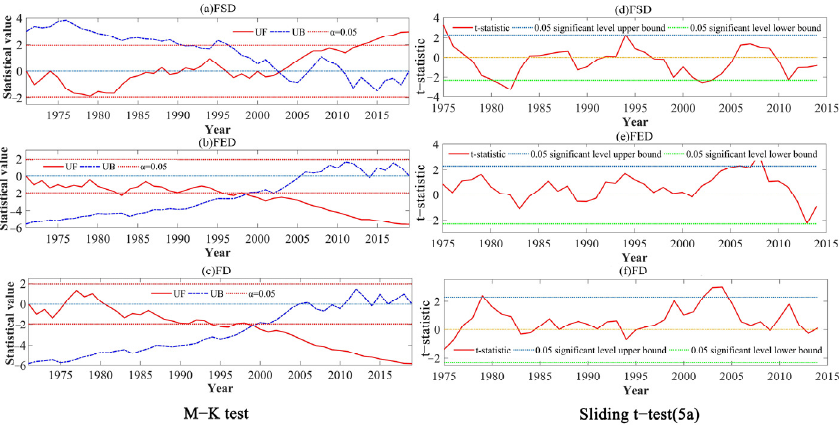
Figure 4. M–K mutation and sliding t -test of interannual variation in key variables of the soil freeze–thaw processes in Heilongjiang Province.